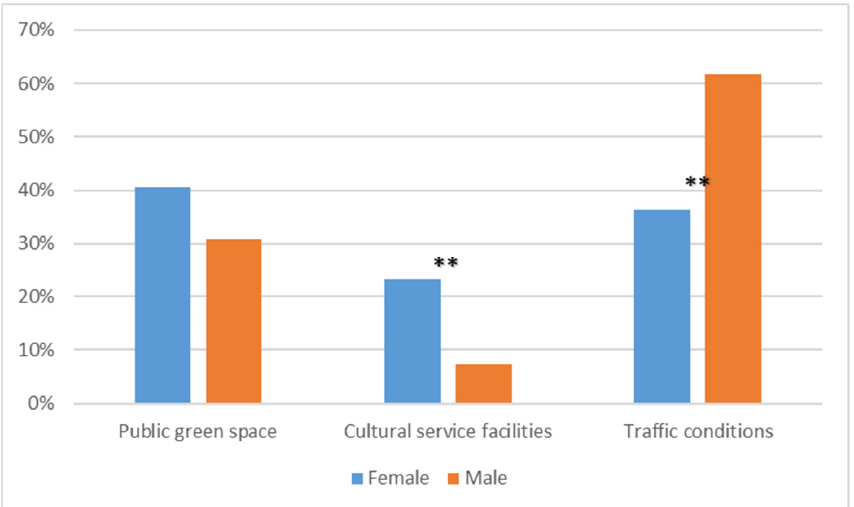
Figure 6. Variations in demand for public infrastructure improvements as perceived and preferred by female and male respondents. Asterisks indicate significance level: ** means p ≤ 0.01.